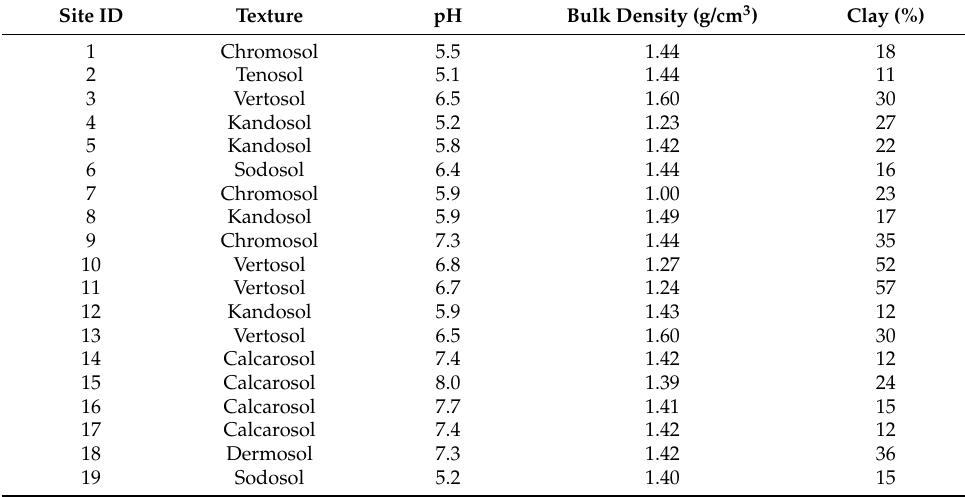
Table 2. Soil texture for 19 sites in Australia.